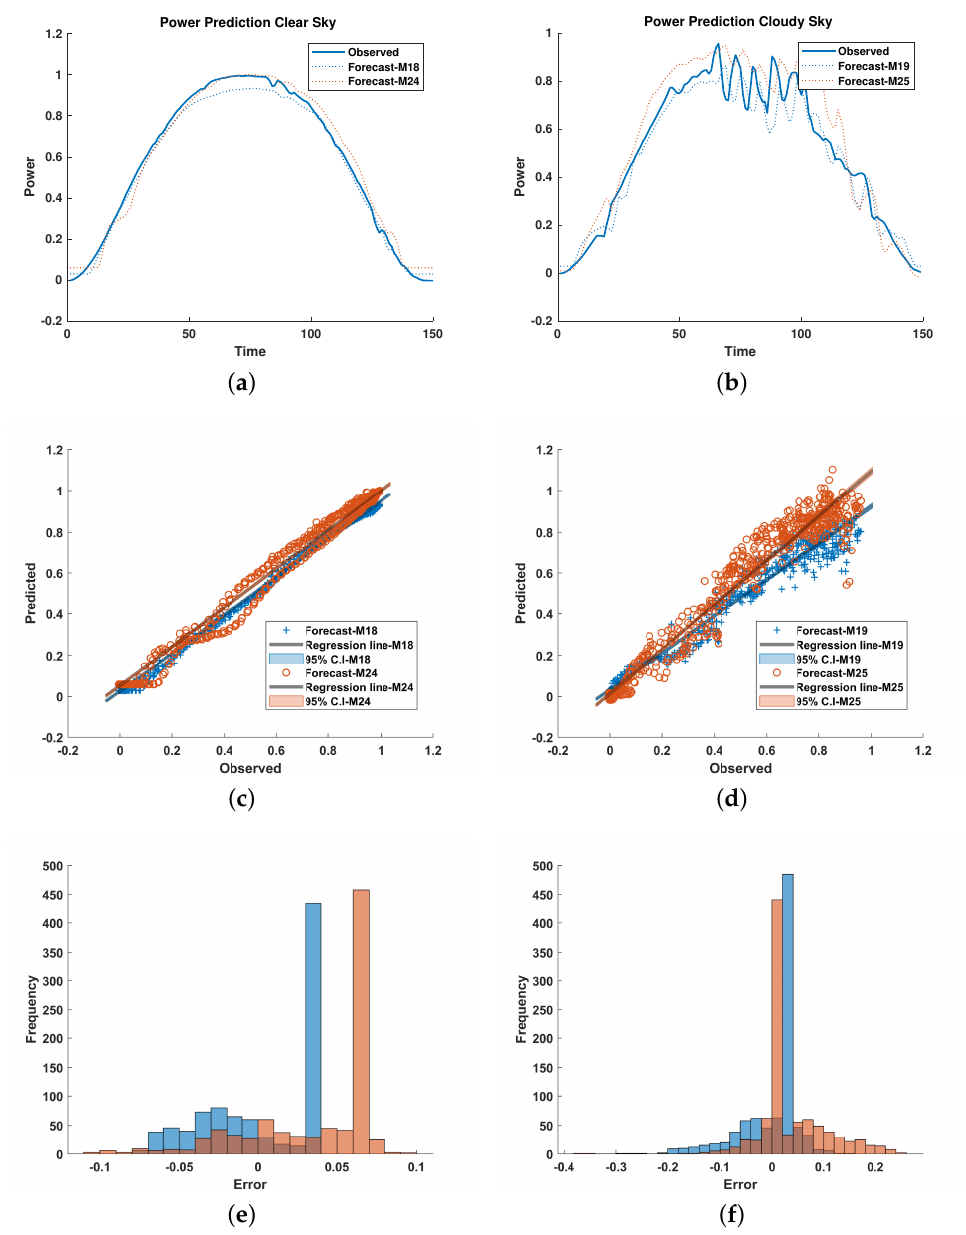
Figure 10. Comparison of different models under clear and cloudy days at time steps = 15: ( a ) Power prediction under clear sky. ( b ) Power prediction under cloudy sky. ( c ) Scatter plot under clear sky. ( d ) Scatter plot under cloudy sky. ( e ) Frequency of forecast error under clear sky. ( f ) Frequency of forecast error under cloudy